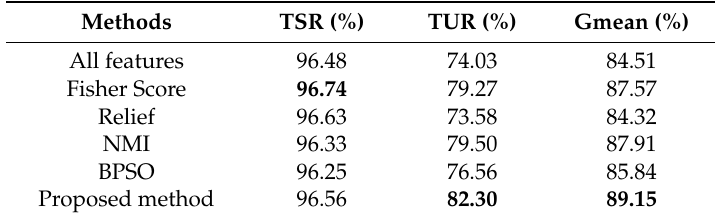
Table 8. Comparison of the results of different feature selections.